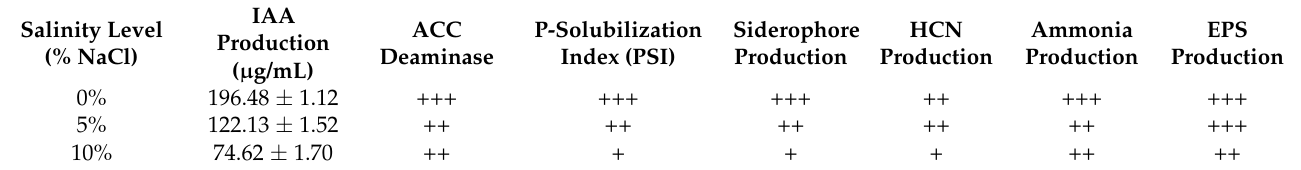
Table 1. Plant growth promoting attributes of strain ASN-1.